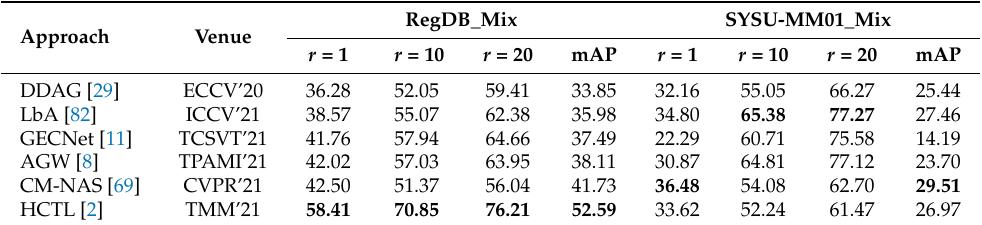
Table 4. Rank-1 accuracy (%) and mAP (%) performance of state-of-the-art methods on RegDB_Mix and SYSU-MM01_Mix. Bold numbers are the best results. All approaches listed in this table are reproduced by us.